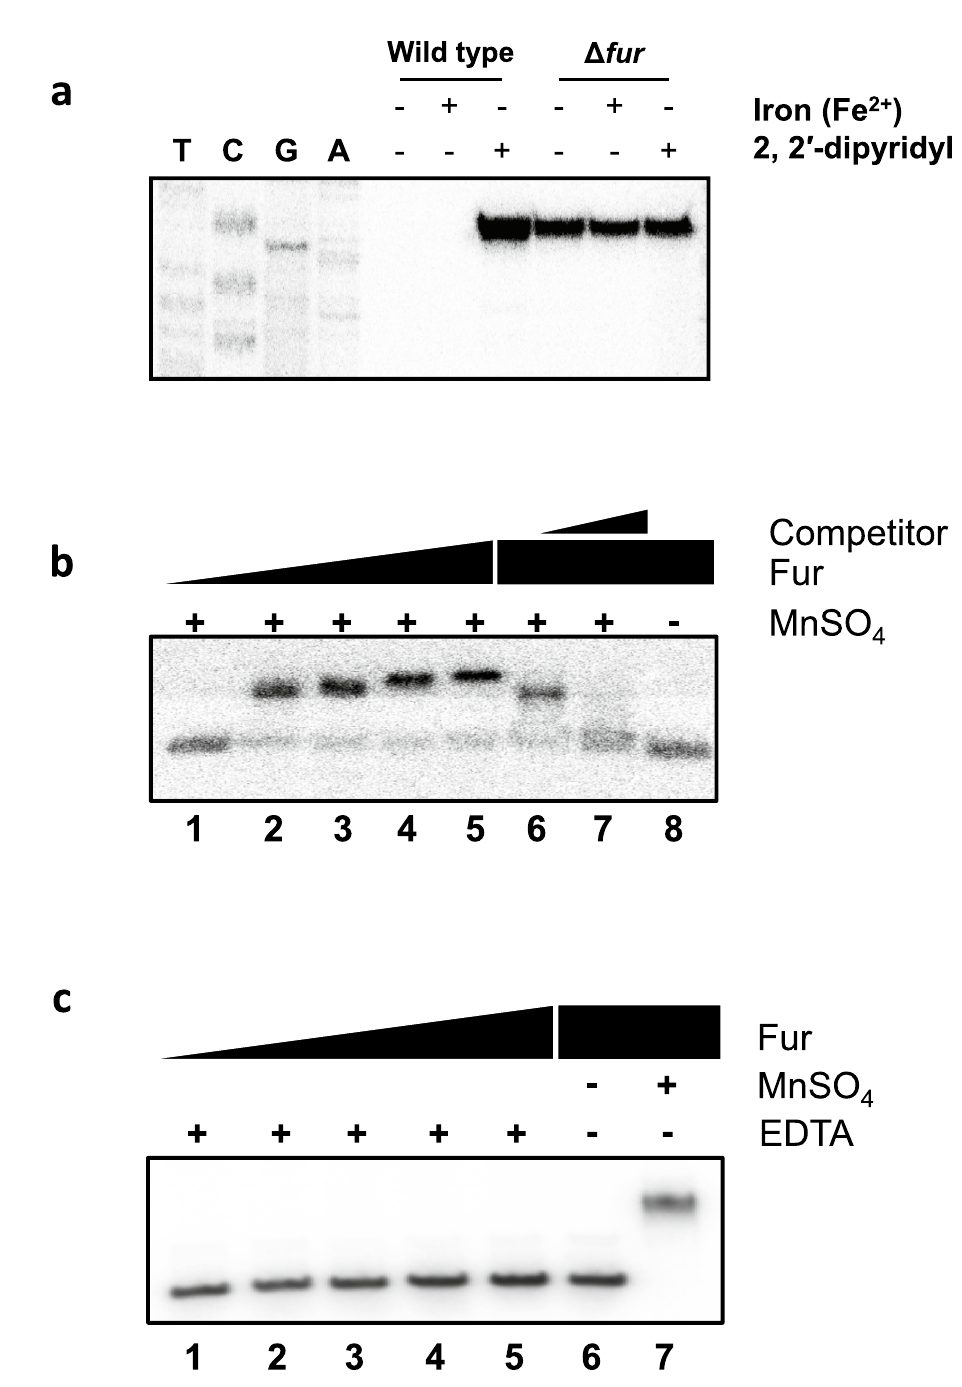
Figure 2. Expression of RyhB is dependent on Fur and iron concentrations. ( a ) Primer extensions were carried out to assess the level of RyhB expression with and without Fur and iron. Wild type MO6 and a fur mutant were cultured in LB supplemented with either 25 μM of FeSO 4 or 200 μM 2, 2 ′ -dipyridyl. After RNA extraction, the RyhB transcript was quantified by primer extension using primer RyhB-PE (Supplementary Table S2). Sequencing ladders generated by the same primer are included. ( b ) Gel shift assay of a 32 P-labeled DNA fragment of the region upstream of ryhB with increasing amounts of Fur in the presence of the divalent cation MnSO 4 . Lanes 1 through 5 are Fur concentrations of 0, 100, 200, 400, and 600 nM, respectively. Lanes 6 and 7 include 600 nM of Fur incubated with probe in the presence of either 260 ng or 720 ng of non-labeled probe, respectively. ( c ) Gel shift assay of 32 P-labeled ryhB probe with increasing amounts of Fur in the presence of 10 mM EDTA. Lanes 1 through 5 are Fur concentration of 0, 100, 200, 400, and 600 nM, respectively. Lane 6 includes 600 nM of Fur without EDTA, and lane 7 includes 600 nM of Fur and MnSO 4 . In figs. 2b and c, the upper bands are to be labeled with ‘Fur-probe complex’ and the lower bands with ‘Free probe’ just like in Fig.